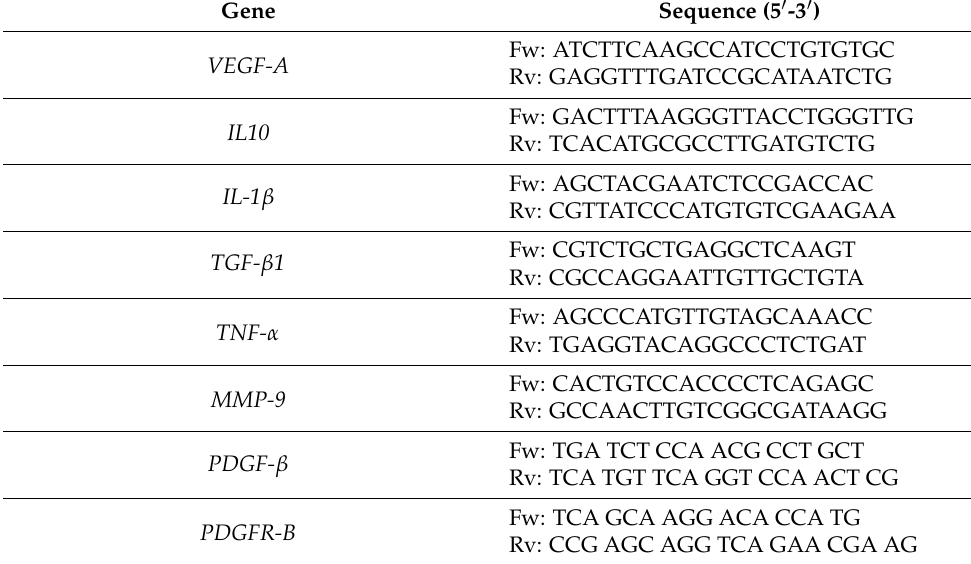
Table 1. Set of primers used for